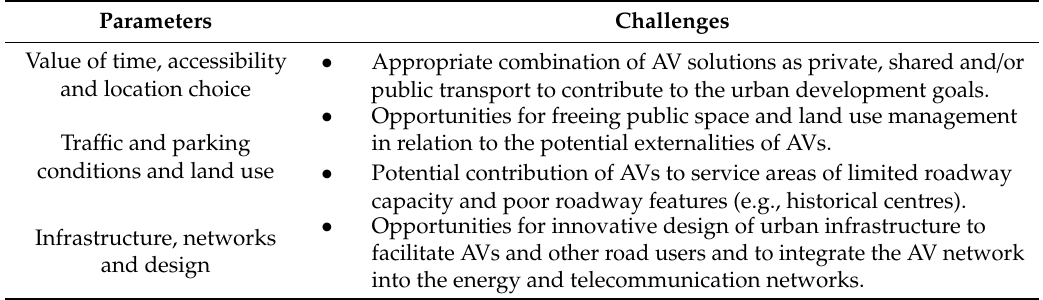
Table 1. Parameters of impacts of autonomous vehicles (AVs) for passenger road transport on urban development and relevant challenges for urban